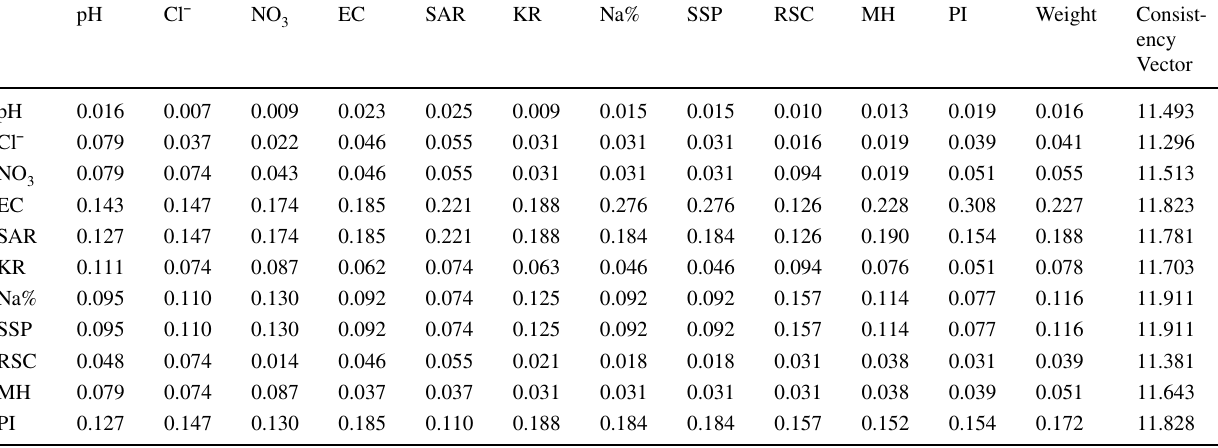
Weight Consist- ency